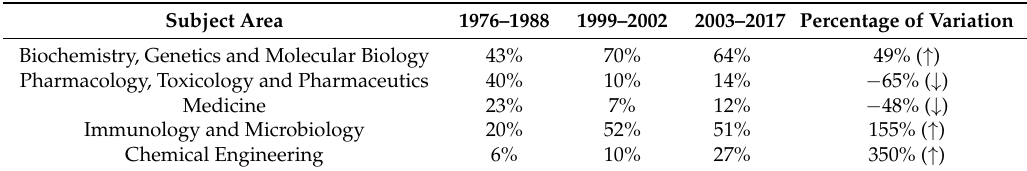
Table 3. Subject areas of studies on CA production by S. clavuligerus in the chemical engineering discipline between 1976 and 2017.